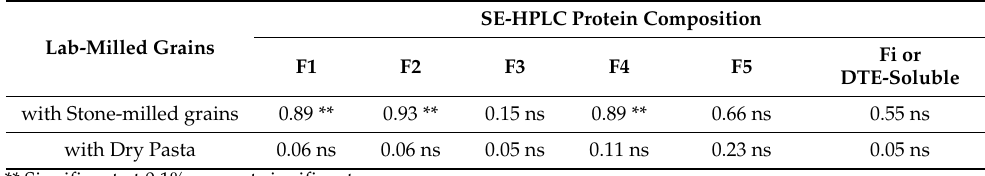
Table 10. Correlations between the protein fractions analyzed on ground grains and those analyzed on semolina and dry